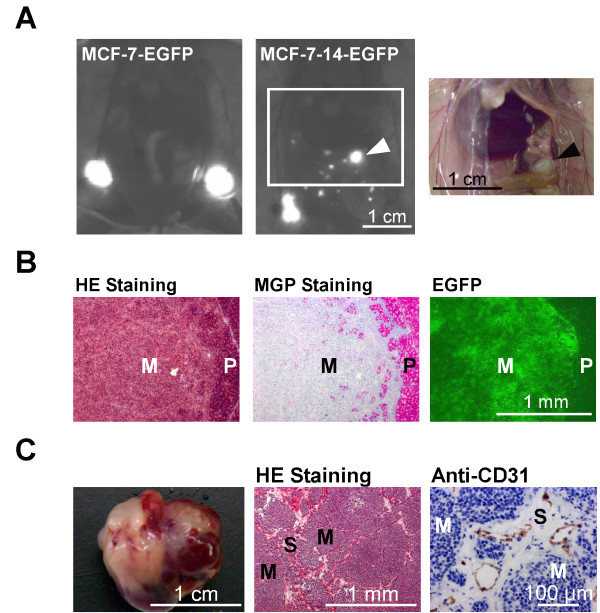
Metastatic abilities of MCF-7 and MCF-7-14 cells in mouse xenograft model. (A) In vivo scanning of EGFP-expressing breast cancer cells in mice at 4 weeks after implantation into the mammary fat pad. In an MCF-7-14-EGFP-bearing mouse, metastasis to the pancreas (arrowhead) was imaged, corresponding to the photo of the abdomen. (B) EGFP-positive region in panel A was analyzed by HE and MGP staining, or unstained sections were analyzed for EGFP fluorescence. Metastasized MCF-7-14-EGFP cells (M) invaded pancreatic parenchyma (P). (C) Representative pancreas metastasis 12 weeks after implantation of MCF7-14-EGFP cells. Pancreas metastasis showed strong stromal (S) and angiogenic responses (brown) closely intermingled with metastasized tumor cells (M).